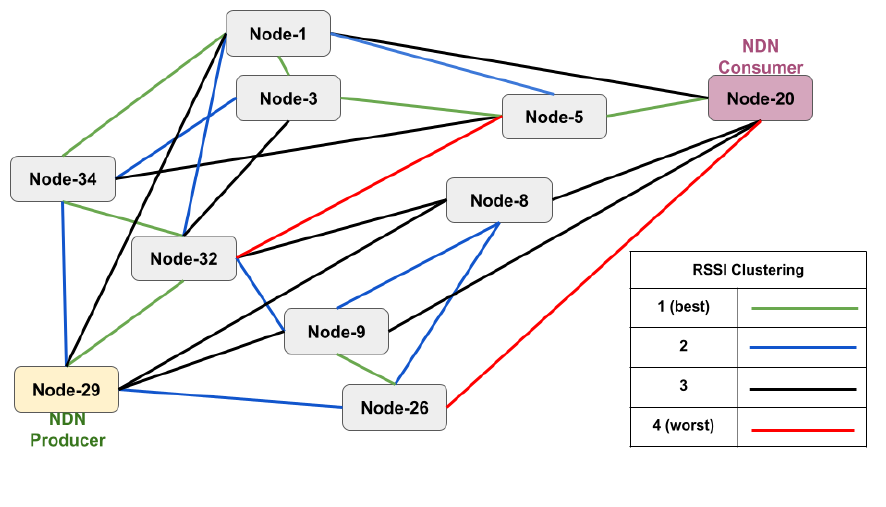
Figure 10. RSSI clustering results among network